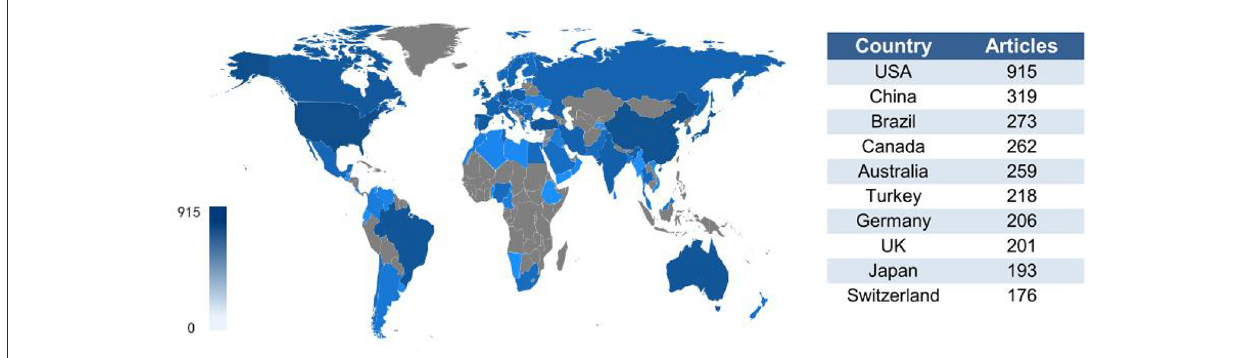
FIGURE2 A visualization of publications by country based on publication counts.